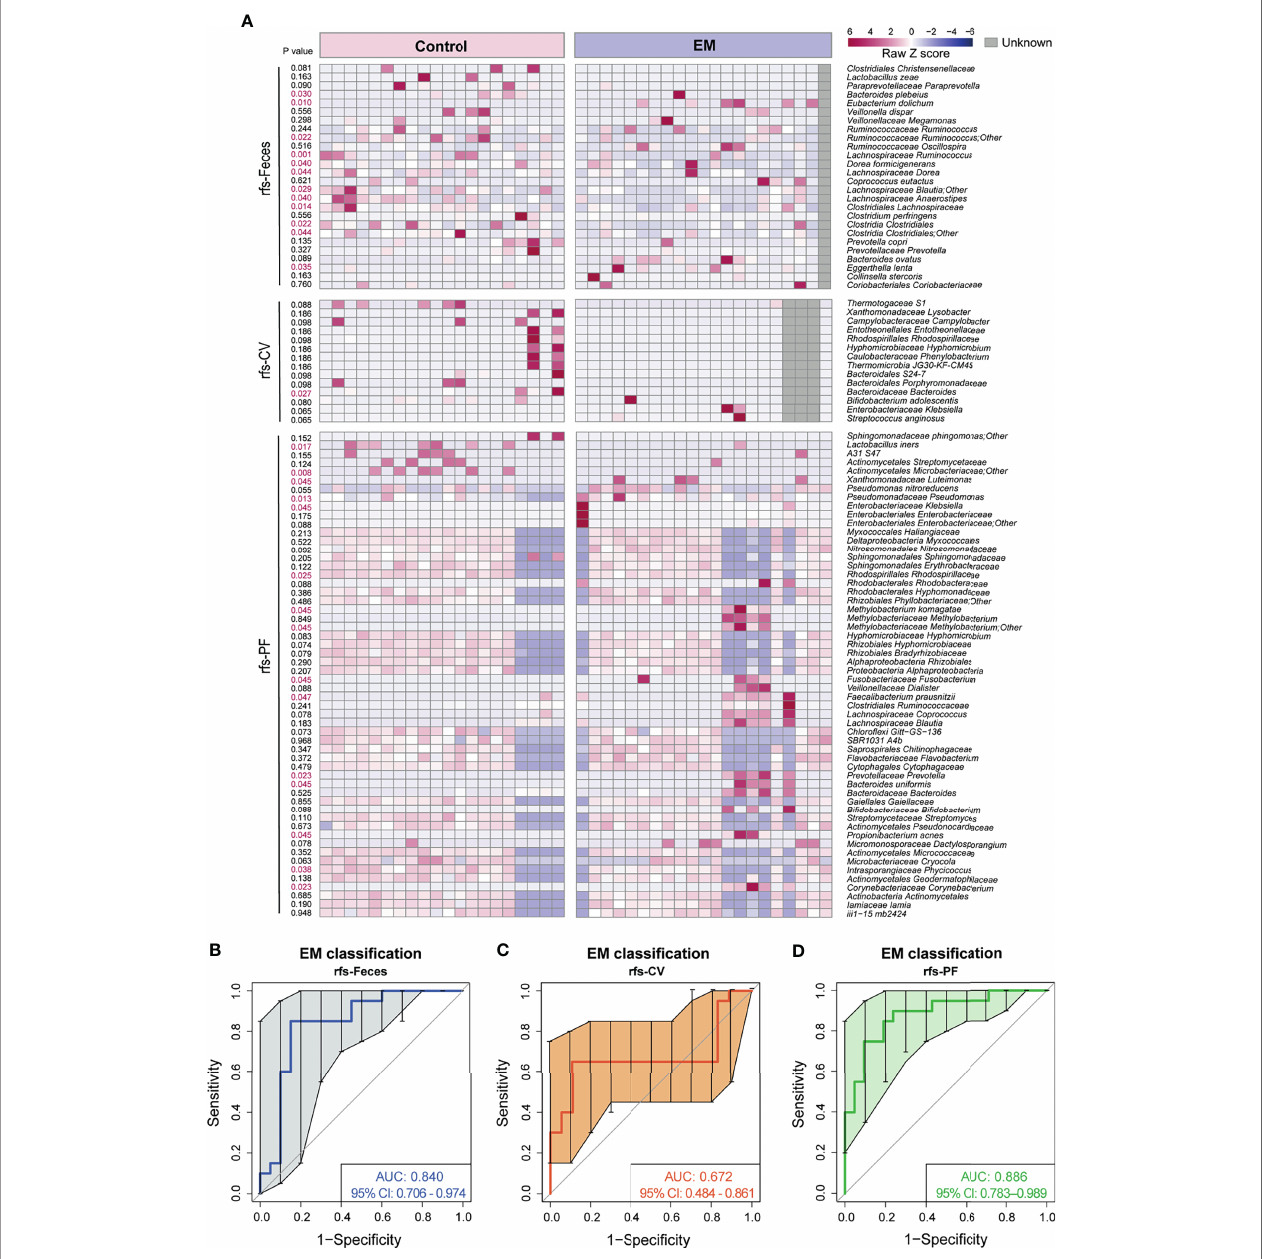
FIGURE 5 | Novel models trained on random forest selected taxa to predict EM. (A) Heatmap of random forest selected species union. (B – D) Curves of receiver operating characteristics for classi fi cation of EM based on random forest selected fecal taxa, cervical mucus taxa, and peritoneal fl uid taxa shown in the heatmap